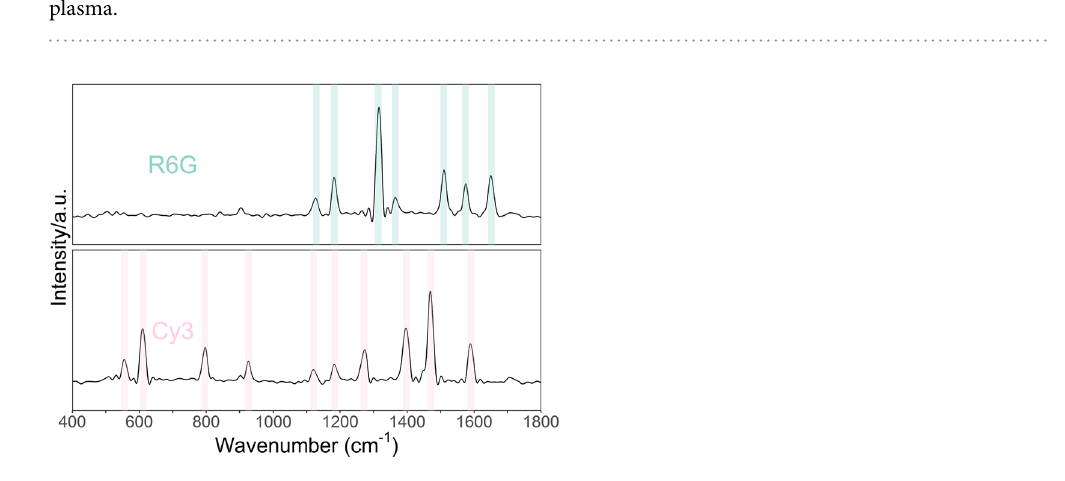
Figure 2. SERS of the 2 fluorescence